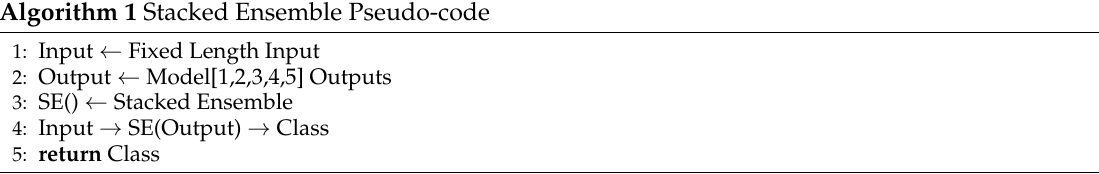
Figure 6. The Stacked Ensemble Architecture.